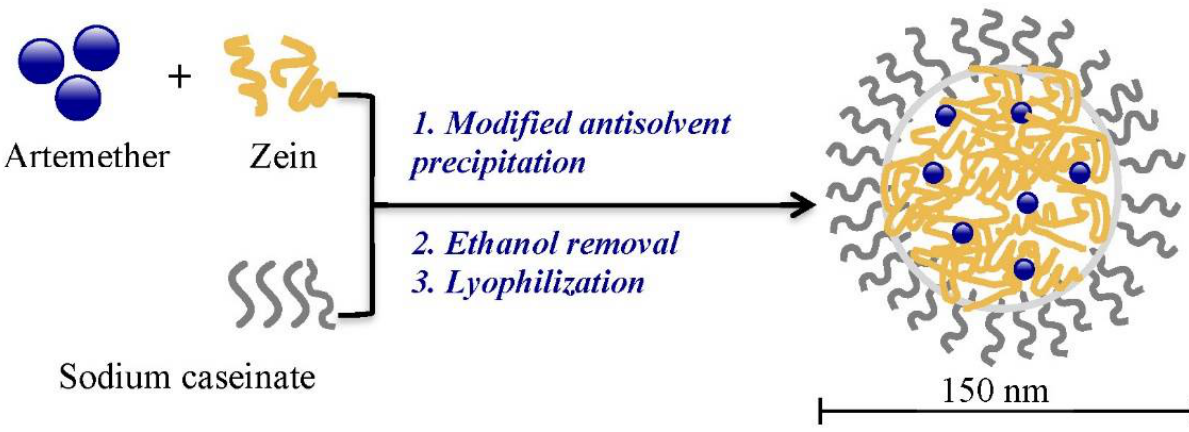
Figure 2. Preparation of artemether-loaded zein nanoparticles.